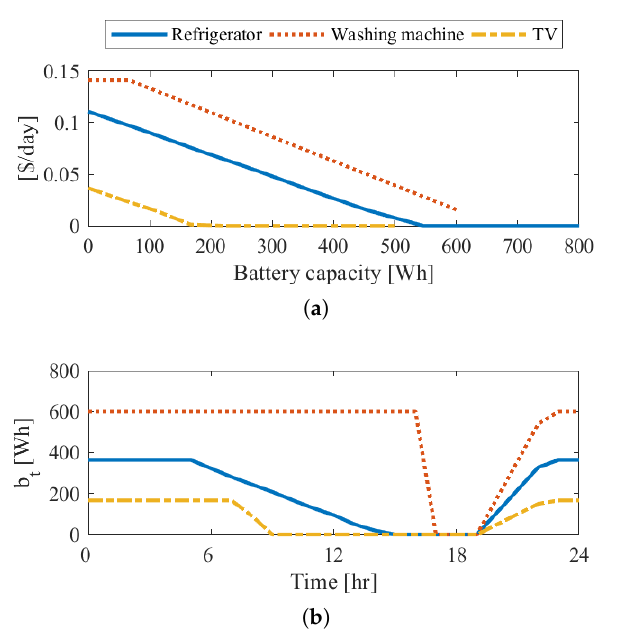
Figure 4. Optimal battery capacity analysis results of case 1, δ 1 = 0.9, δ 2 = 0.9. ( a ) Home appliance daily electricity cost. ( b ) Home appliance battery SoC, K ref = 360 Wh, K wash = 600 Wh, K TV = 160